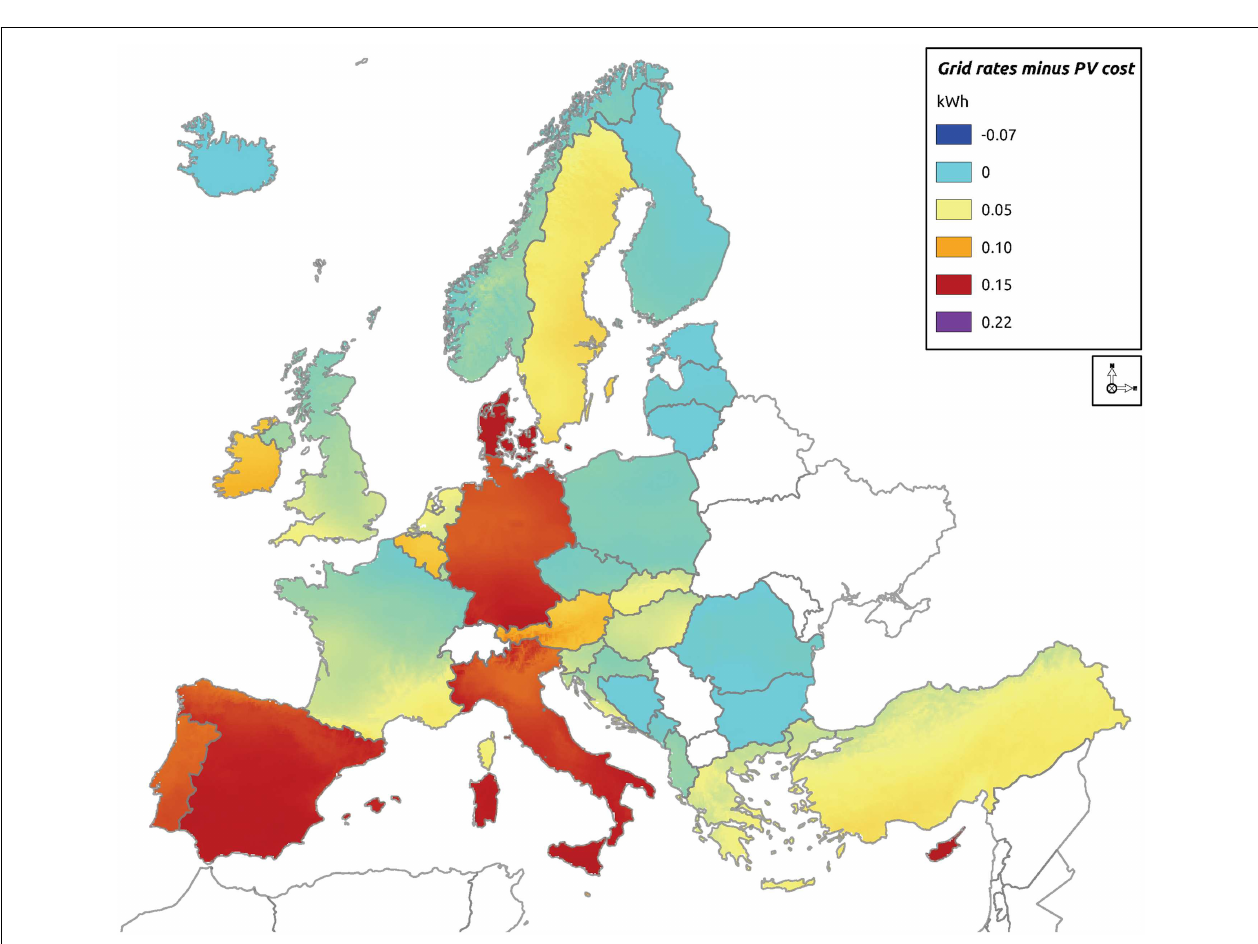
FIGURE 5 | Difference between grid electricity rates for households and basic PV costs